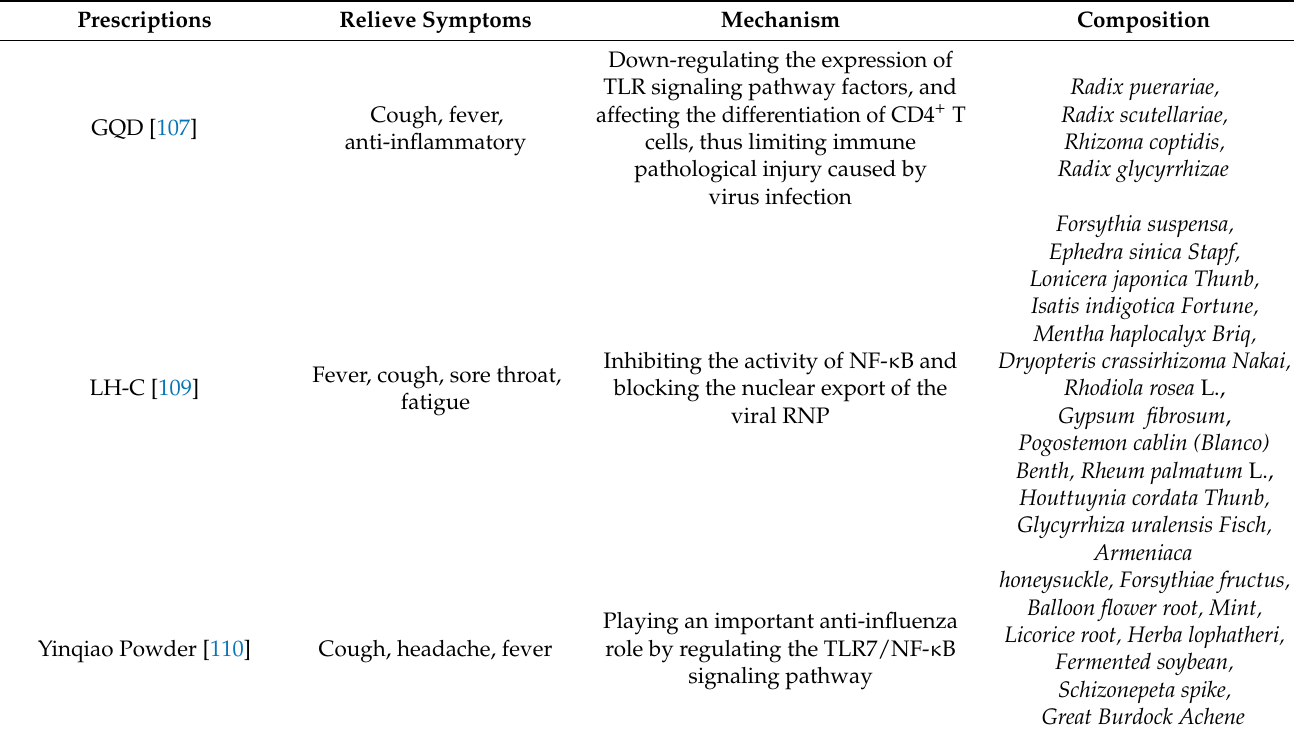
Table 3. List of Traditional Chinese Medicine